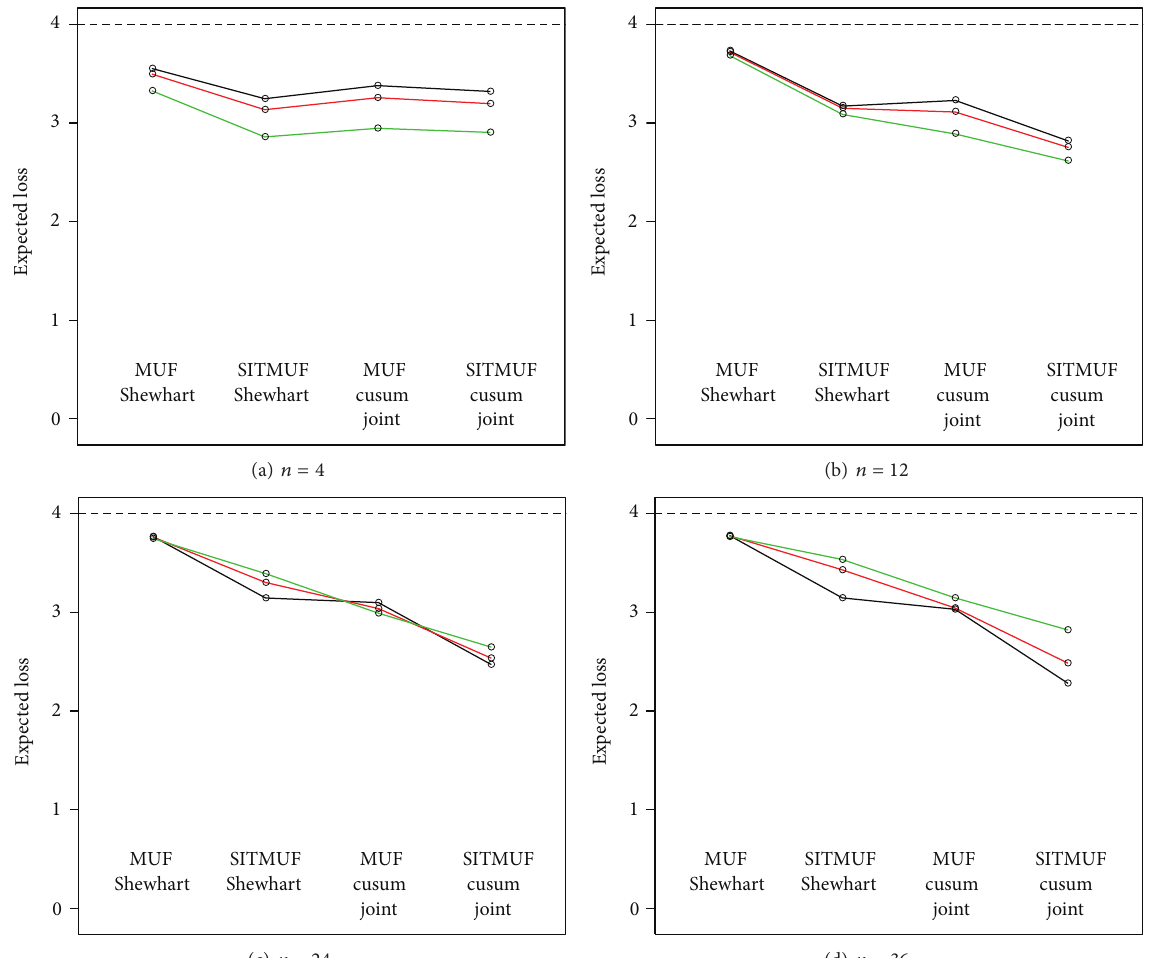
Figure 3: Expected loss for protracted threat, 𝜎 𝑇 = 0.1 , 𝑀 = 4 . (Colors black, red, and green correspond to Σ 1 – Σ 3 . Dashed lines are for